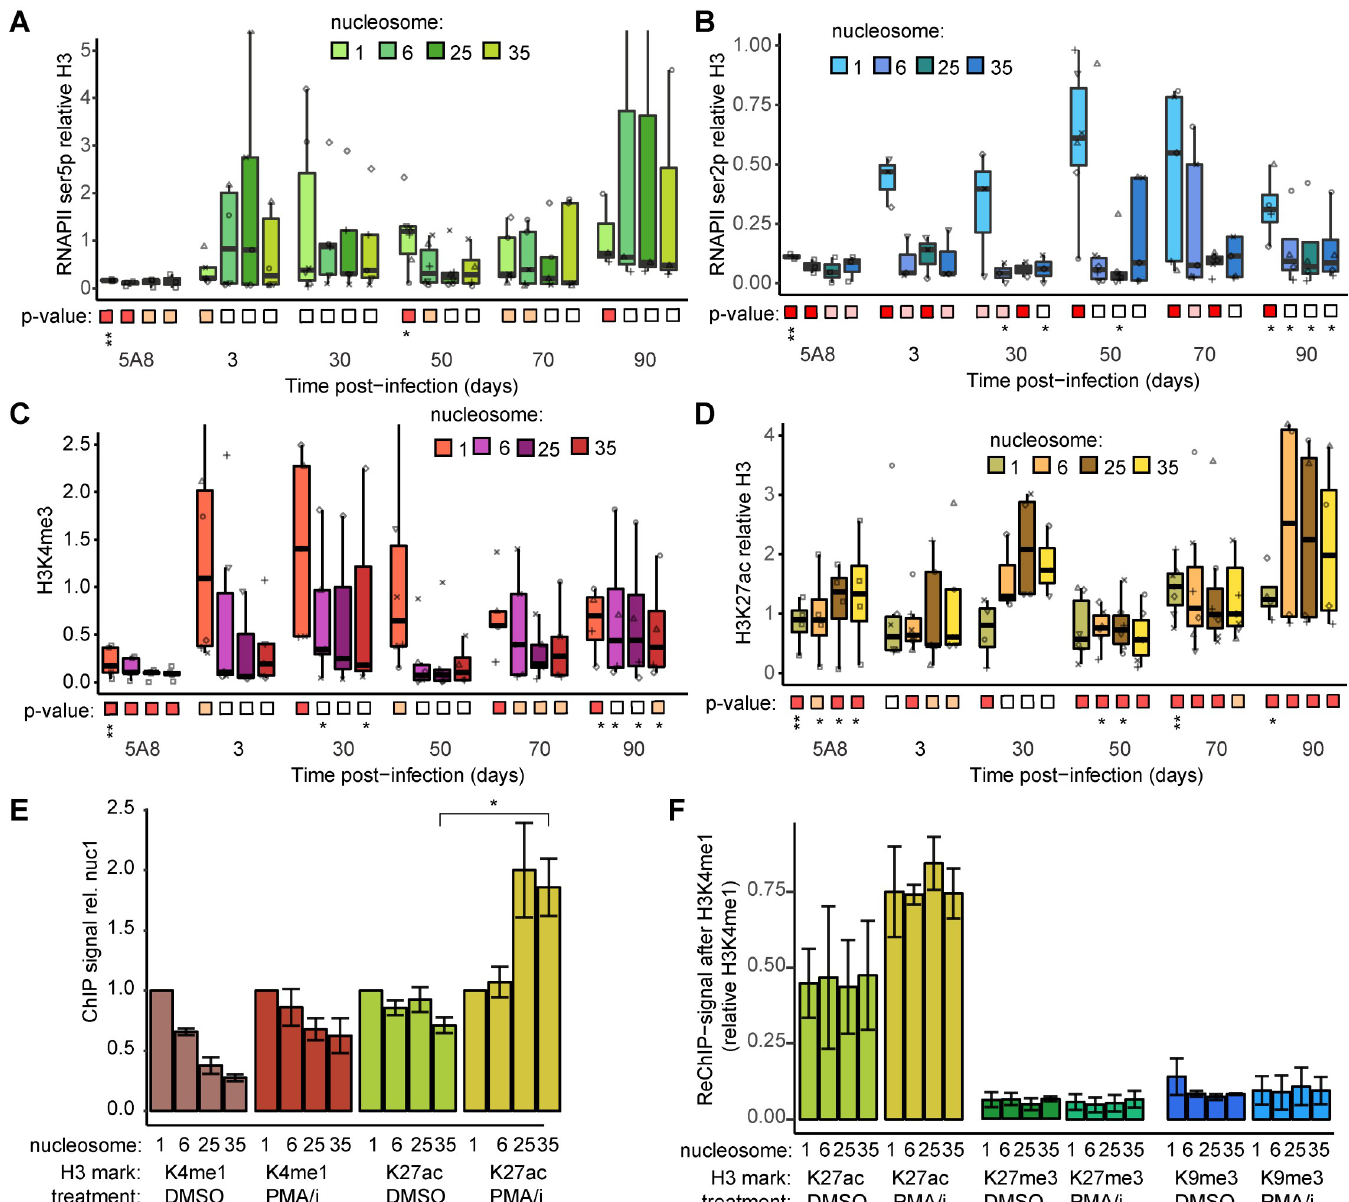
Fig 6. RNAPII and active marks remain along HIV-1 proviral chromatin. ( A ) ChIP-qPCR signal for initiated RNA Pol II (CTD ser5 phosphorylated). ( B ) ChIP-qPCR signal for elongating RNA Pol II (CTD ser2 phosphorylated). ( C ) ChIP-qPCR signal for promoter mark H3K4me3 (D ) ChIP-qPCR signal for enhancer mark H3K27ac. Boxplots show data of T-cells from HIV-negative donors ( n = 3, in duplicate). (A-D) Statistics calculated as in Fig 5A and 5B. ( E ) ChIP-qPCR for H3K4me1 and H3K27ac in 5A8 cells, following 24h DMSO or PMA/i treatment ( n = 3), � p < 0.05, unpaired t-test. ( F ) ReChIP in 5A8 cells of H3K4me1 followed by